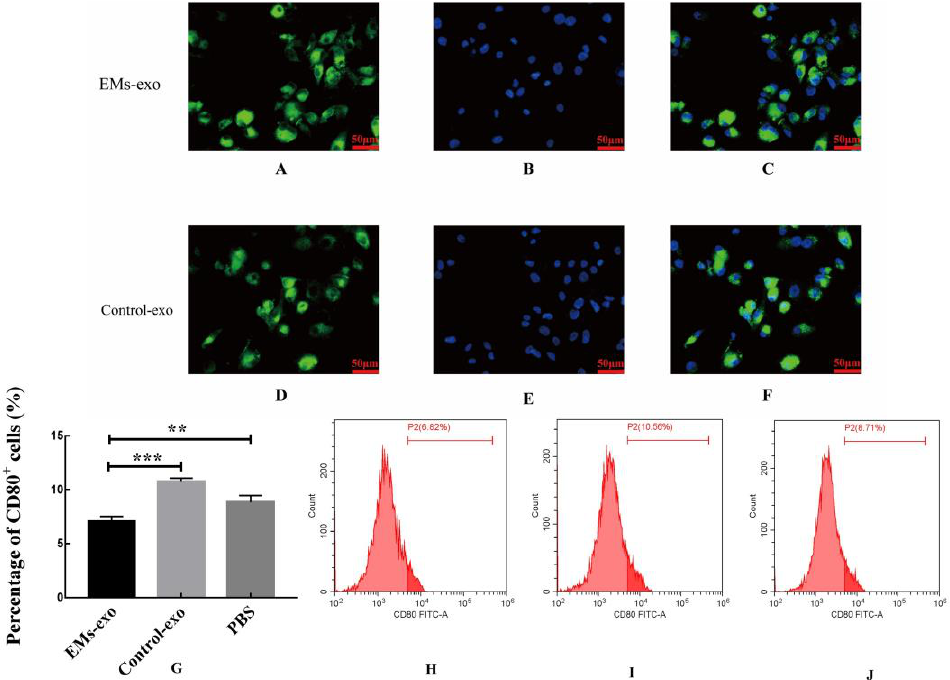
Figure 2. Exosomes of the uterine aspirate fluid in patients with endometriosis decreased the proportion of CD80 + macrophages. ( A ) Exosomes from the EMs group were labeled with green fluorescence. ( B ) The macrophage nuclei were stained blue. ( C ) The uptake of exosomes from the EMs group by macrophages. ( D ) Exosomes from the control group were labeled with green fluorescence. ( E ) The macrophage nuclei were stained blue. ( F ) The uptake of exosomes from the control group by macrophages. Scale bar: 50 µ m. ( G ) The flow cytometry was used to detect the proportion of CD80 + macrophages. ( H ) The proportion of CD80 + macrophages after intervention with exosomes from the EMs group. ( I ) The proportion of CD80 + macrophages after intervention with exosomes from the control group. ( J ) The proportion of CD80 + macrophages after intervention with PBS. Data are expressed as the mean ± standard error of the mean (SEM) (** p < 0.01, *** p < 0.001).